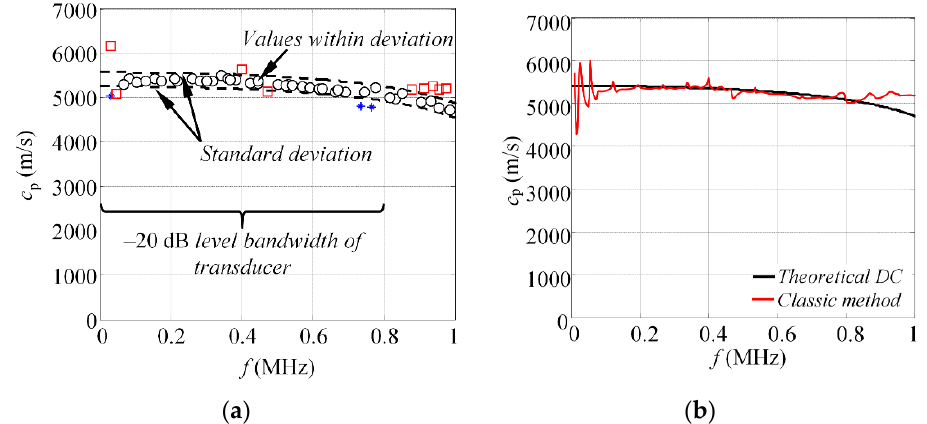
Figure 6. ( a ) The graphic representation of standard deviation, showing the spread of estimated phase velocity values and ( b ) reconstruction of phase velocity dispersion curves using the classic phased spectrum method.